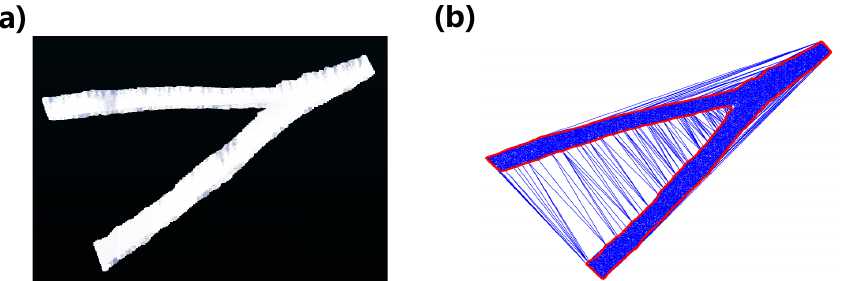
Figure 11. The second group of data-processing results for the Zhangjiakou Wanlong Ski Resort (Parameters: T = 1.8 cm, A = 0.7, D = 38 cm): ( a ) color point cloud; ( b ) ski-track boundary extraction.